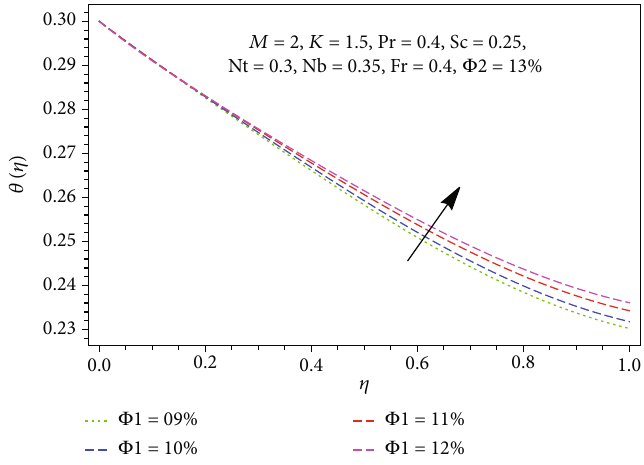
Figure 18: Impact of nanoparticle fraction ϕ